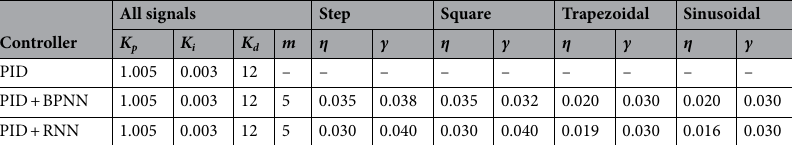
Table 5. The optimal parameters of the different controllers in the experiment tests.